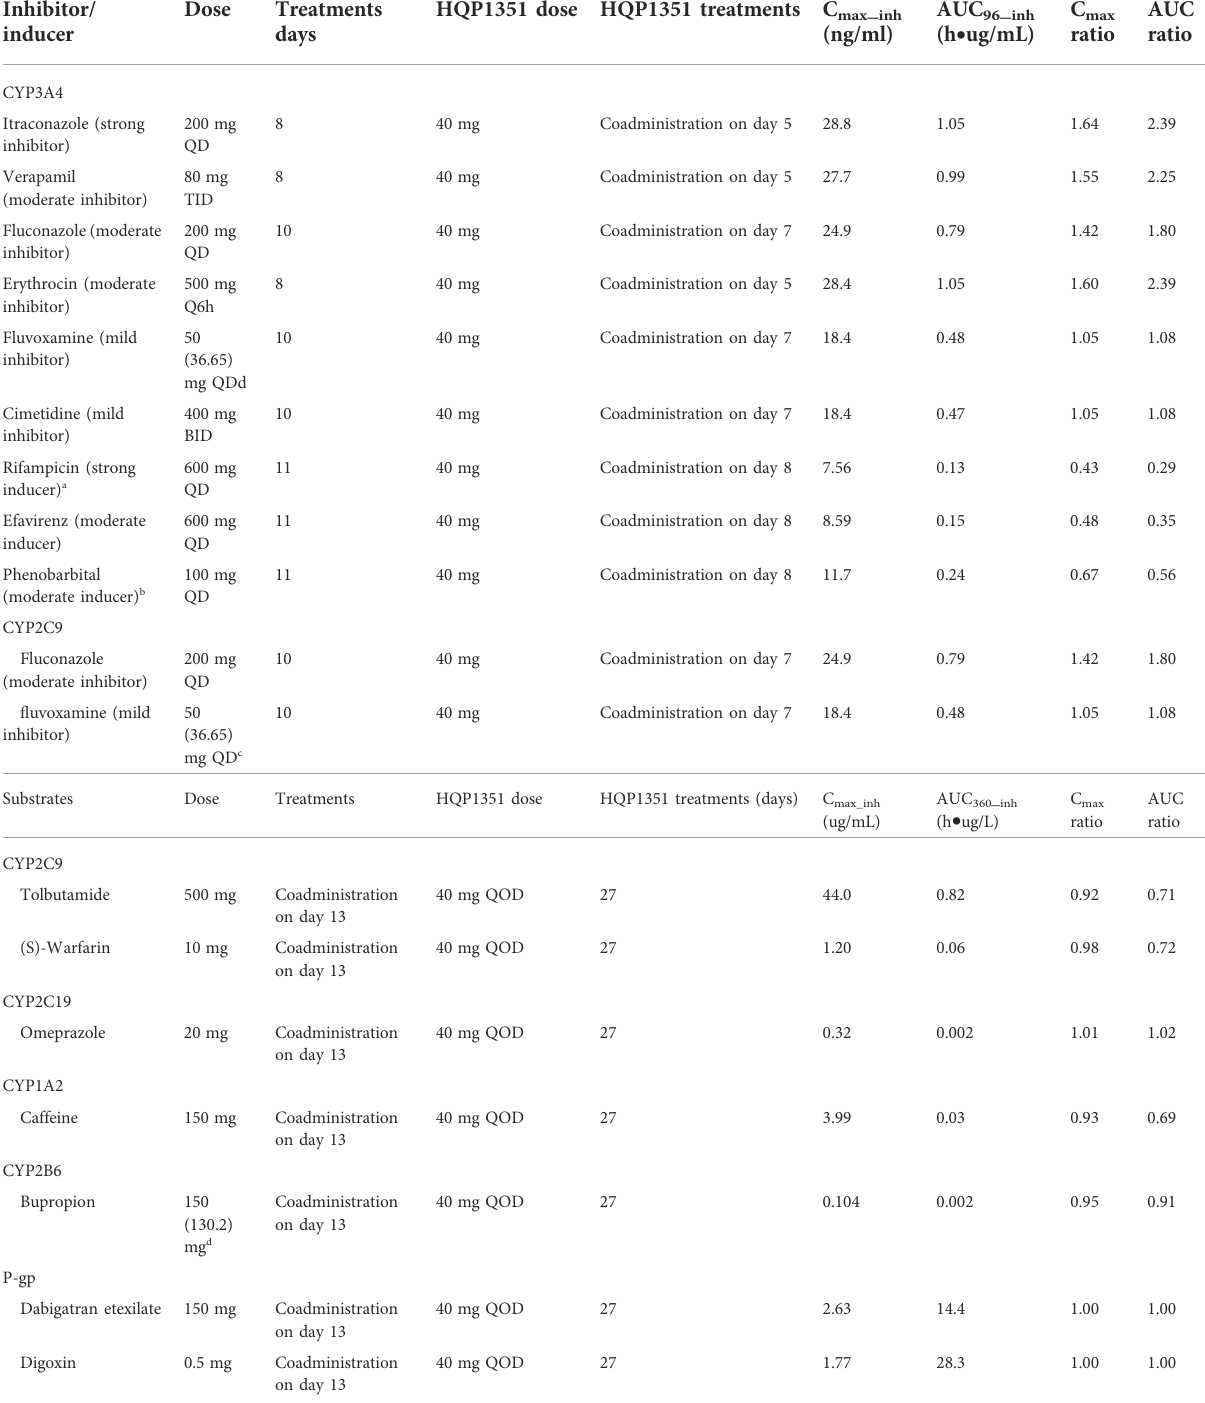
TABLE 2 Simulated C max and AUC ratios of olverembatinib (HQP1351) as victim in the presence and absence of CYP modulators and simulated C max and AUC of CYP substrates when olverembatinib as CYP modulators. Inhibitor/ Dose Treatments inducer